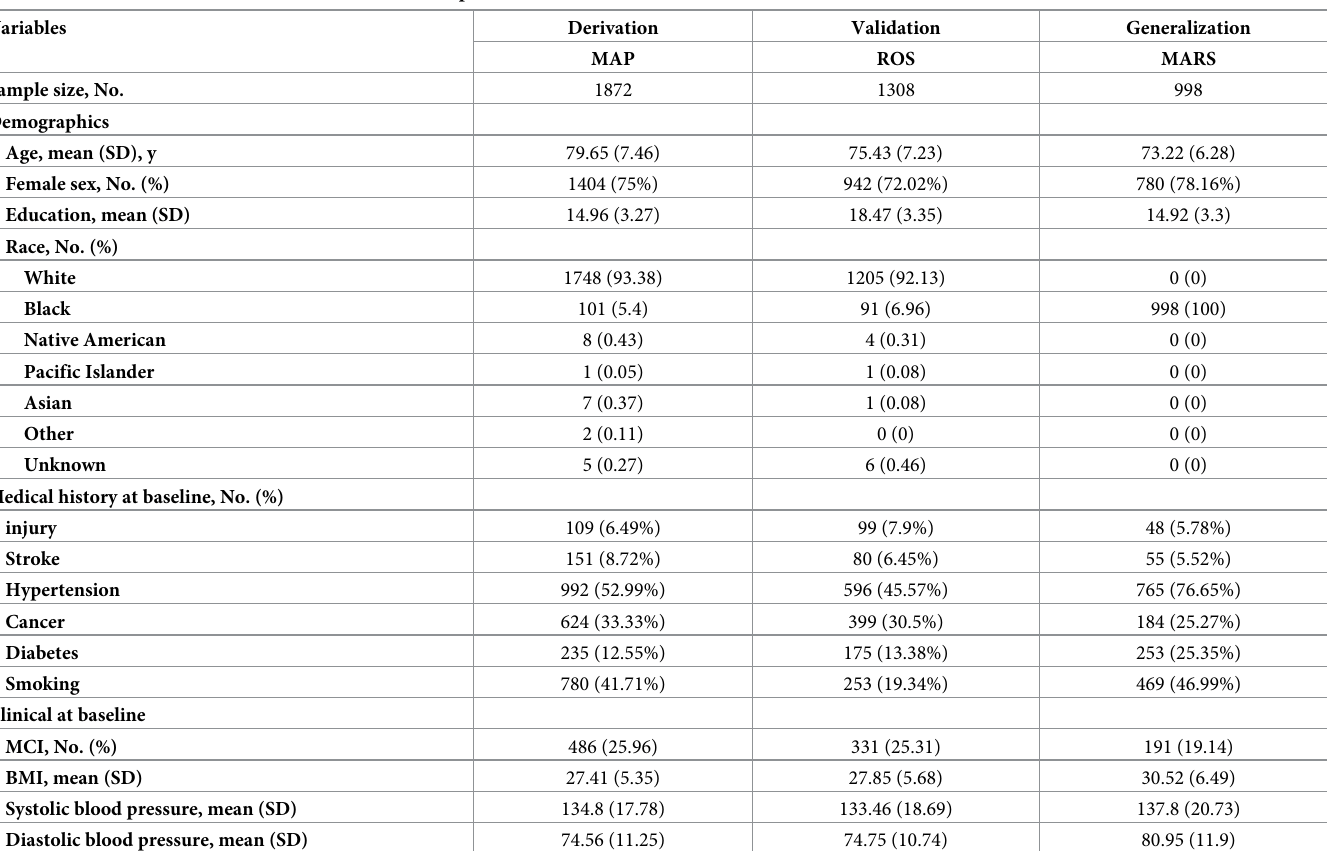
Table 1. Characteristics of derivation and validation samples at